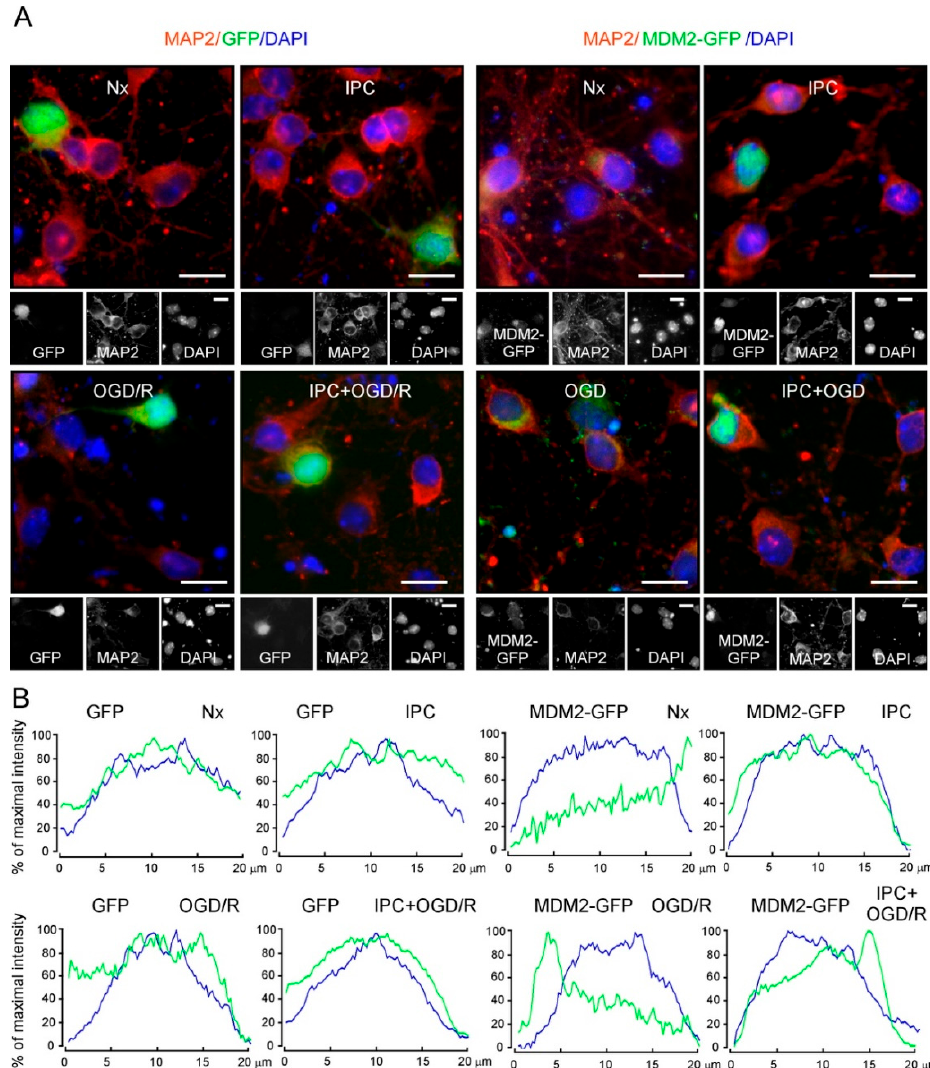
Figure 4. IPC triggers MDM2 nuclear stabilization in cortical neurons after ischemia. Ectopic expression of human MDM2 in neurons (9–10 DIV) is shown. GFP + neurons and neurons expressing human MDM2-GFP for 24 h were subjected to Nx, IPC, OGD/R, and IPC + OGD/R conditions and were analyzed by immunofluorescence. ( A ) Representative image of cortical neurons stained with GFP (green) and MAP2 (red, neuronal marker). Scale bar, 15 μ m. ( B ) Representative cross-sectional intensity profiles for GFP (green) and DAPI (blue) staining of GFP and MDM2-GFP-transfected neurons. Mean fluorescence of MDM2-GFP nuclear/cytosolic intensity ratio calculated from four different neuronal cultures is presented in Figure S2B.